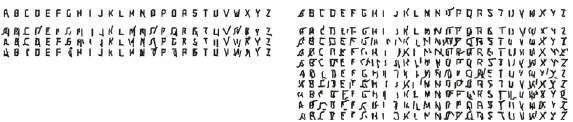
Figure 12: On the left, thearchive (sampled) of theexpressions from a run of evolving stencils guided by the hybrid mechanism. On the right, the archive (sampled) of a run evolving stencils guided by fitness. The top row instances are the fittest stencil found and the remaining ones above them are the archive for the no novelty (on the left) and novelty (on the